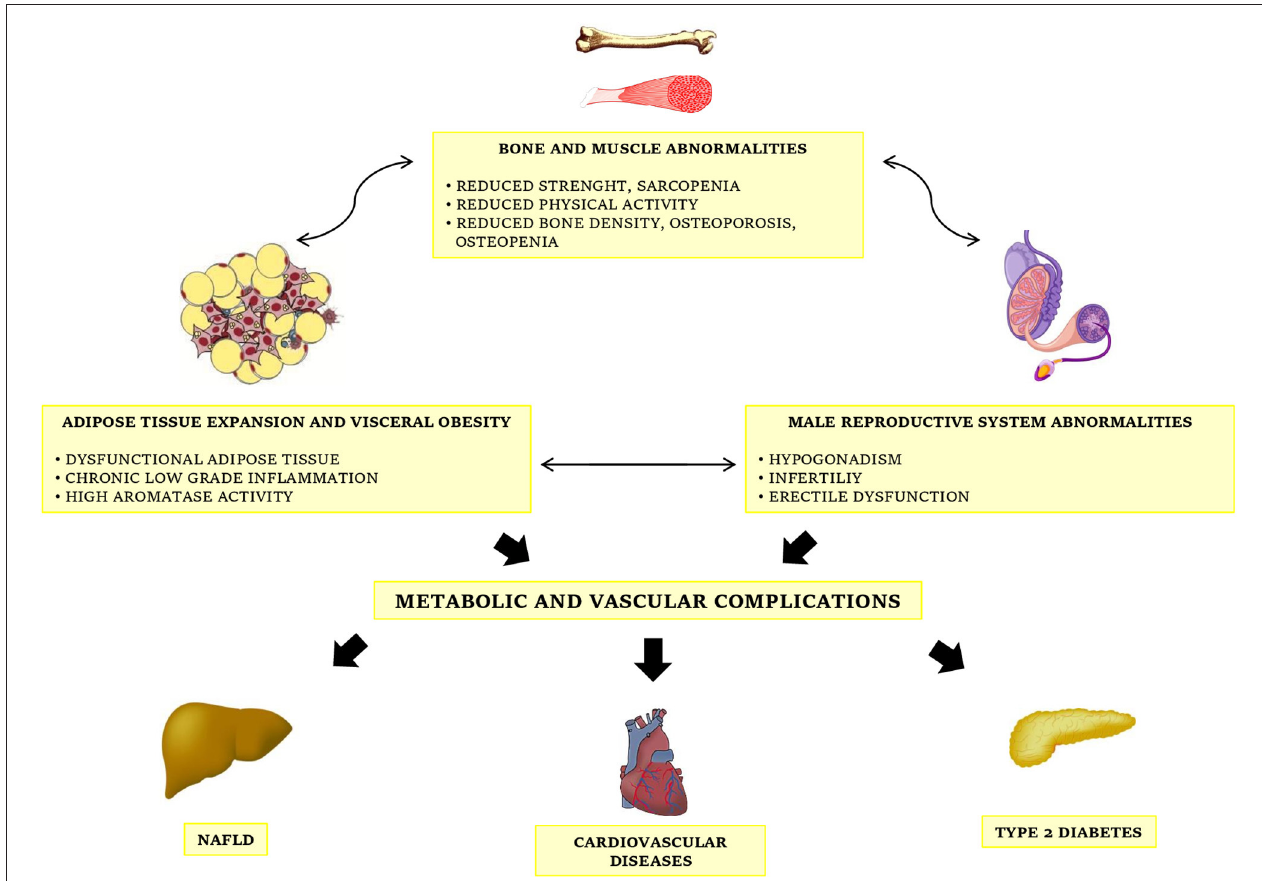
FIGURE 1 | The complex interconnections between obesity, metabolic diseases and male gonadal